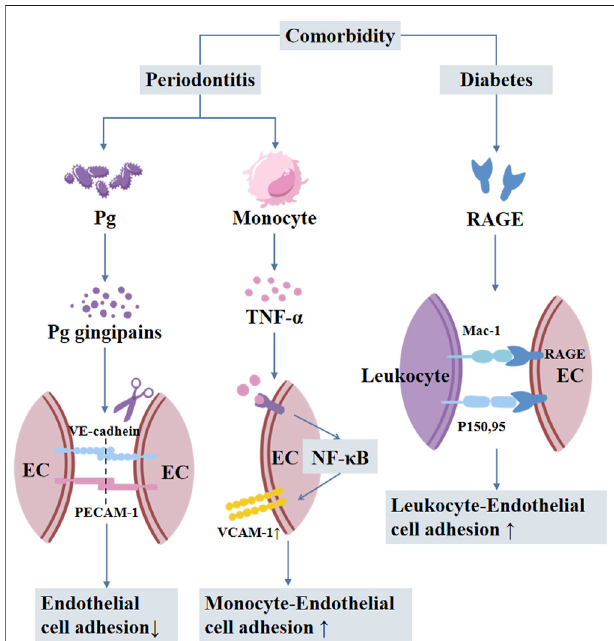
FIGURE 5 | The mechanisms involved in periodontitis-diabetes comorbidity-mediated vascular in fl ammation and atherosclerosis. Pg: Porphyromonas gingivalis; EC: endothelial cells; RAGE: receptor of advanced glycation end products.